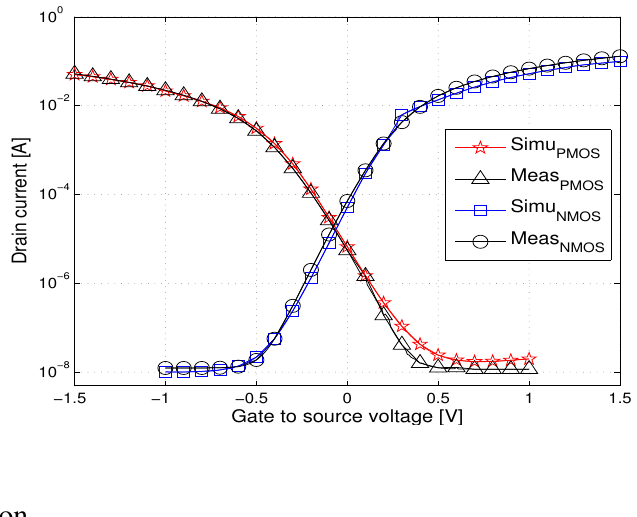
Figure 5. Measured and simulated I L = 0 . 28 µ